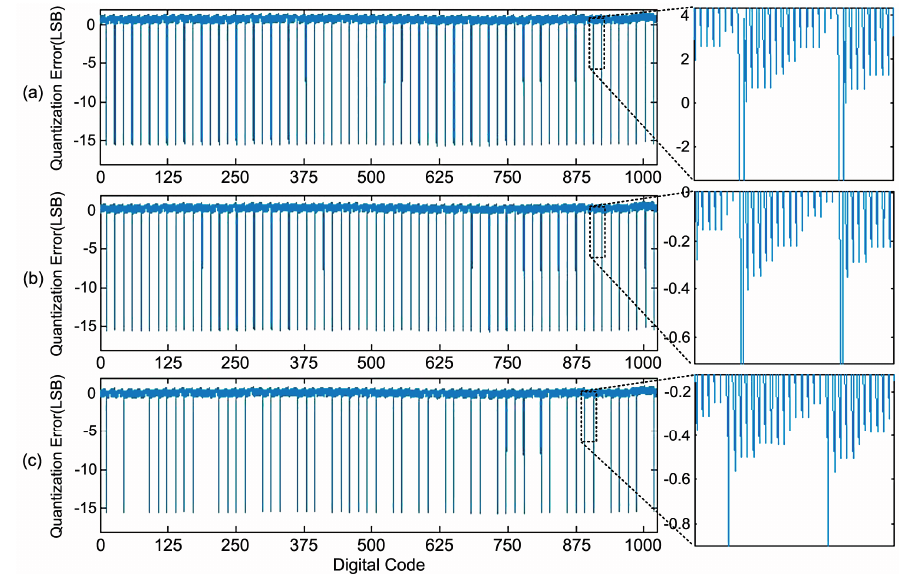
Figure 15. Quantization error without calibration. ( a ) − T clk < Δ T p < − T clk /2; ( b ) − T clk /2 < Δ T p < − 100 ps; ( c ) − 100ps < Δ T p <